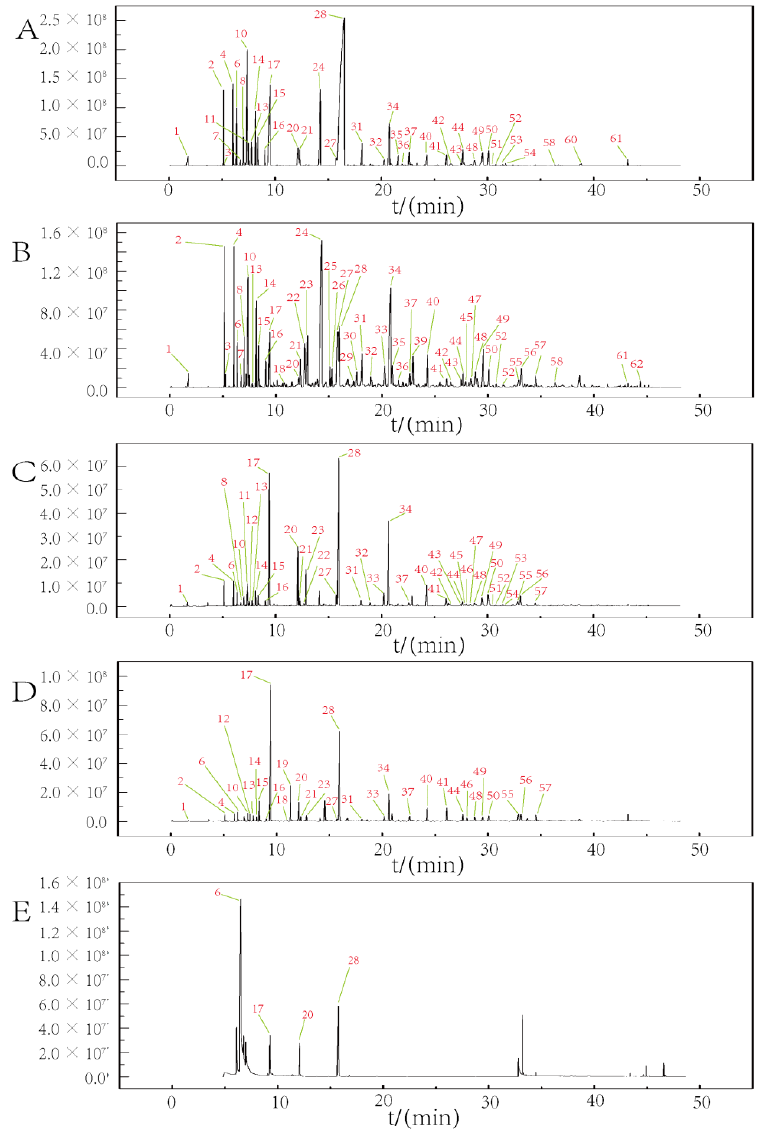
Figure 2. GC-MS total ion chromatogram (( A – E ) corresponded to SJ, SHJ, SHJY, SJY, Reference com- pounds).